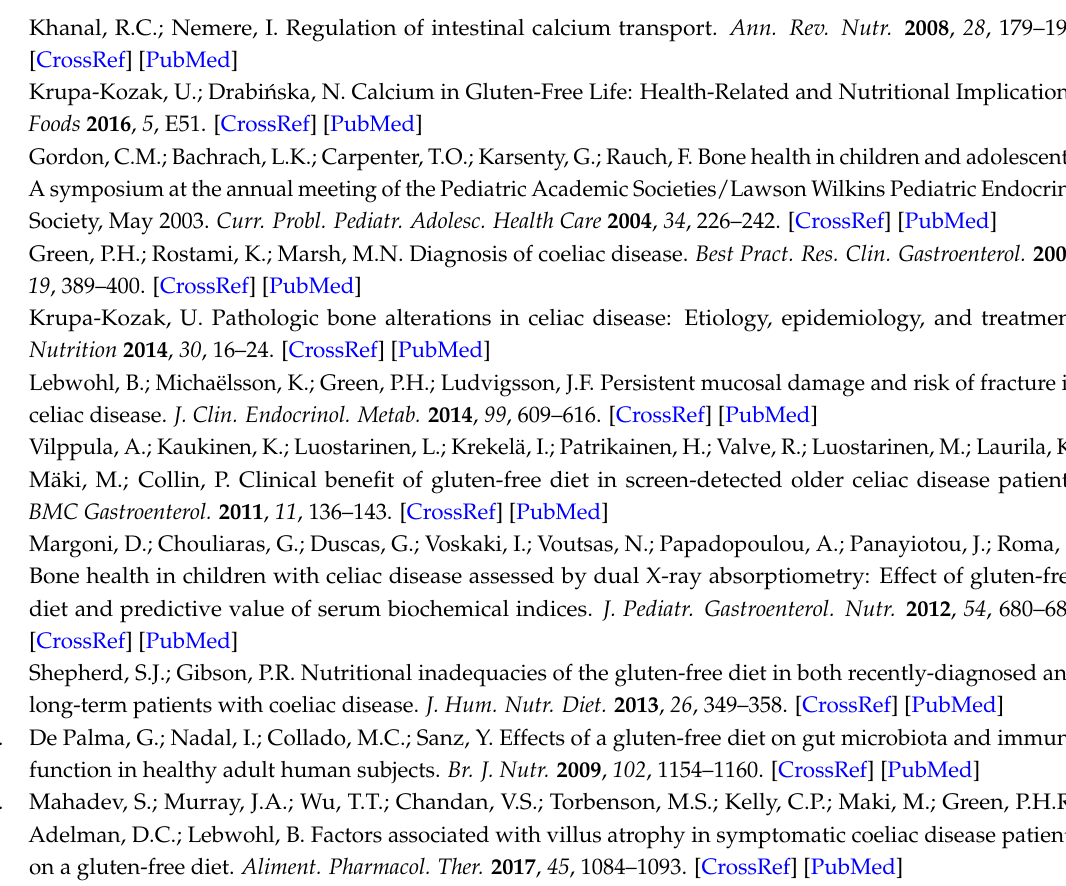
Figure S1: DGGE profiles of rats’ caecal bacteria obtained with universal primers. Rats were fed diet with optimal (O) or restricted (R) calcium supply supplemented with inulin (diet OI and RI, respectively). Arrows indicate band taken for identification which results are shown in a table below. Figure S2. DGGE profiles of rats’ caecal Bacteroides population. Rats were fed diet with optimal (O) or restricted (R) calcium supply supplemented with inulin (diet OI and RI, respectively). Arrows indicate band taken for identification which results are shown in a table below. Figure S3. DGGE profiles of rats’ caecal Lactobacillus population. Rats were fed diet with optimal (O) or restricted (R) calcium supply supplemented with inulin (diet OI and RI, respectively). Arrows indicate band taken for identification which results are shown in a table below. Figure S4. DGGE profiles of rats’ caecal C. leptup group (clostridial cluster IV). Rats were fed diet with optimal (O) or restricted (R) calcium supply supplemented with inulin (diet OI and RI, respectively). Table S1: Nutritional composition of experimental gluten-free diets, Table S2: Primers and amplification conditions used for qualitative (PCR-DGGE) analysis of caecal microbiota, Table S3: Denaturing gradient applied for separation of PCR products in DGGE technique; Table S4: Primers used for real-time PCR